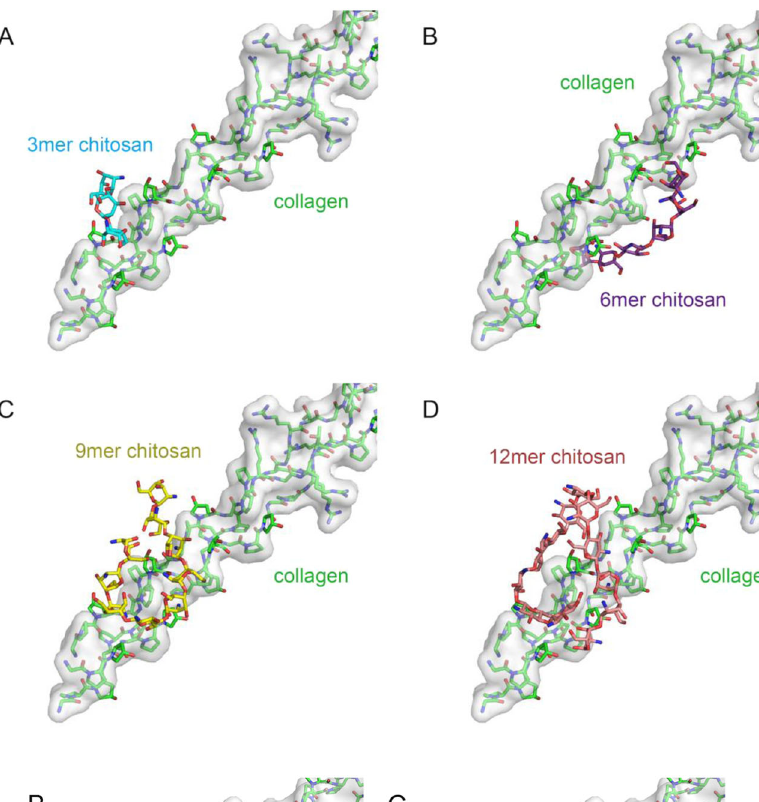
Fig. 2 The best docking results of the chitosan with 3mer ( A ), 6mer ( B ), 9mer ( C ), and 12mer ( D ) to the synthetic collagen peptide (PDB code:2F6A). The synthetic collagen peptide is colored green and shown as a transparency surface model. The chitosan polymers are colored cyan (3mer), purple (6mer), yellow (9mer), and pink (12mer), respectively